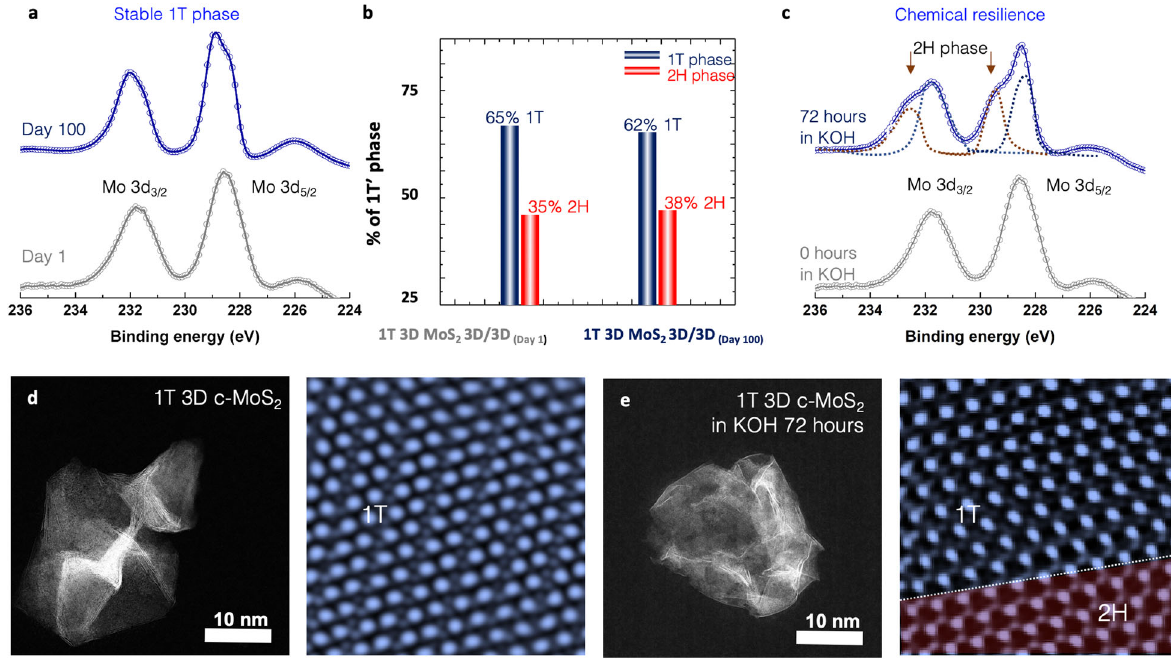
Fig. 6 Chemical resilience of MoS2 3D/3D homostructures. a , b By tracing the evolution of 1T ′ Mo 3d core level photoemission peaks at 228.1 eV (Mo 3d 5/2 ) and 231.3 eV (Mo 3d 3/2 ), it can be seen that 1T ′ polymorphs remain stable and only show a minor decrease of 3% after placing in a N 2 - fi lled glovebox for 100 days. c XPS characterization, d, e TEM images along with false-colored HAADF analysis (1T ′ clustered Mo in blue and 2H trigonal prismatic Mo in red), collectively attest to the premise that intricate morphological features help to preserve the conductive 1T ′ phase after continuous electrochemical cycling in 1 M KOH for 72